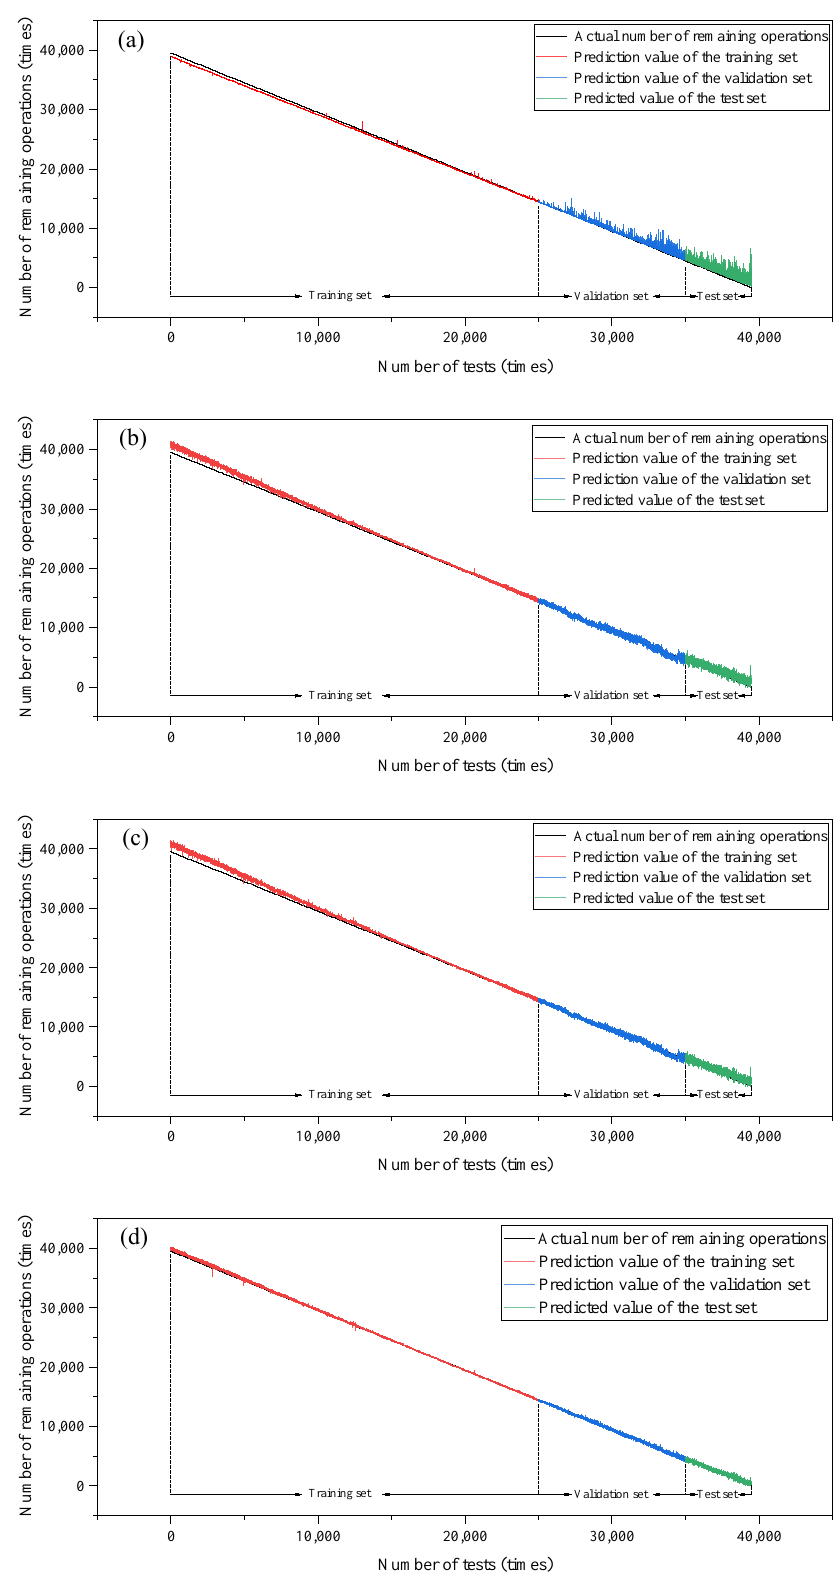
Figure 21. Comparison of prediction results after feature selection. ( a ) RNN, ( b ) LSTM, ( c ) GRU, ( d )